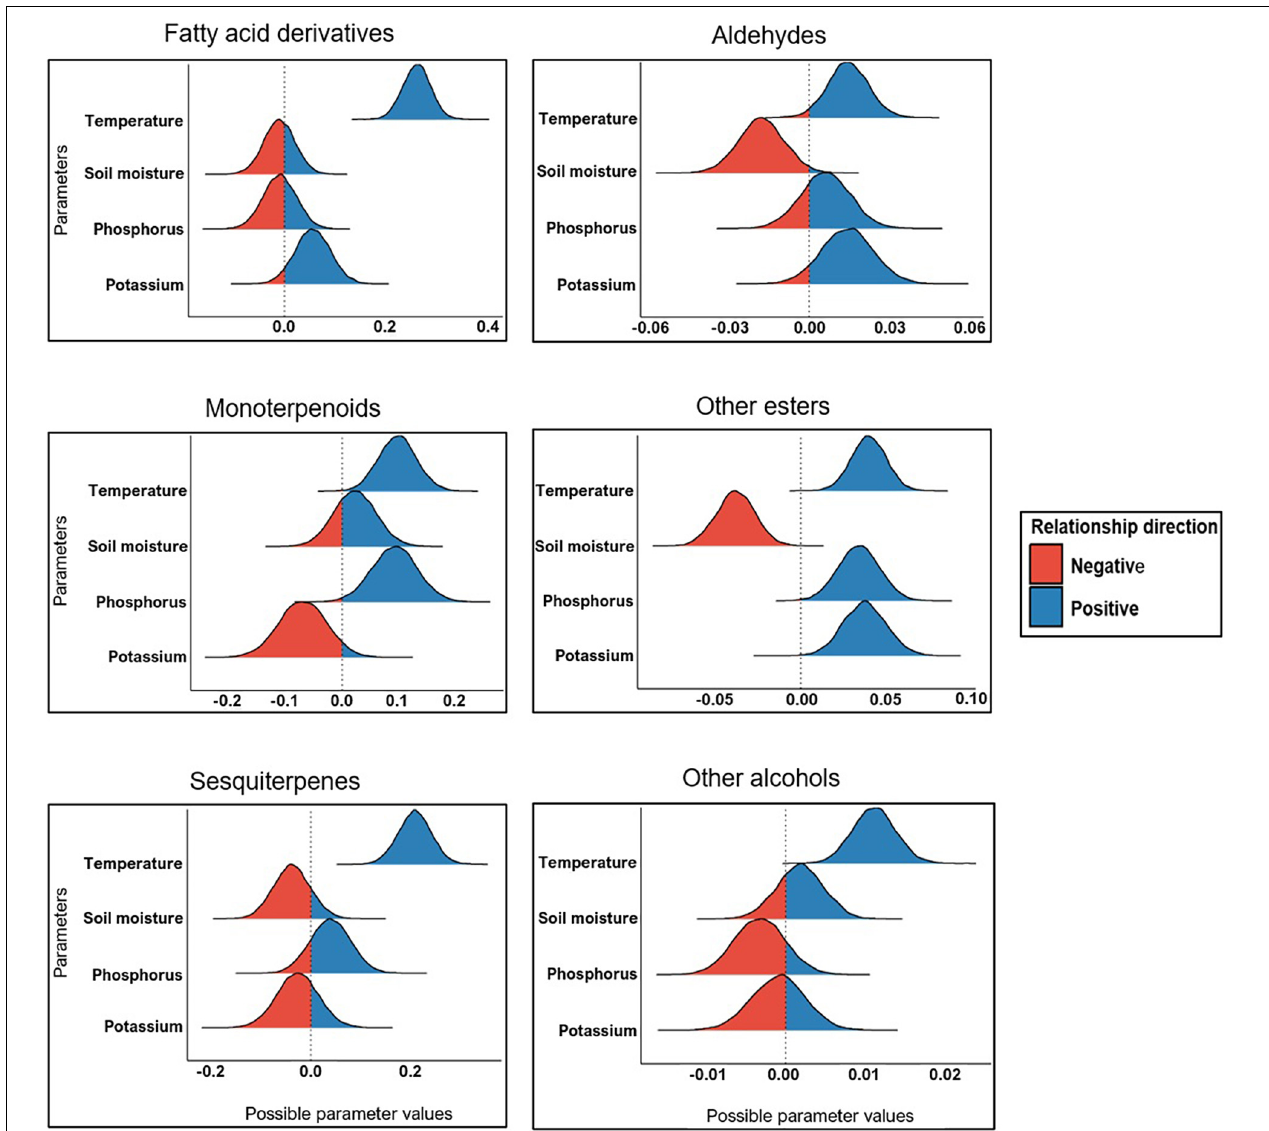
FIGURE 6 | Relationship between environmental variables and major chemical classes. Bell shapes indicate the distribution of covariates (predictors) draws after the Markov chain Monte Carlo (MCMC) simulations. Distribution that is fully below or above the reference line on zero indicates a strong, consistent relationship, and colors (red or blue) show the direction of the relationship (either positive or